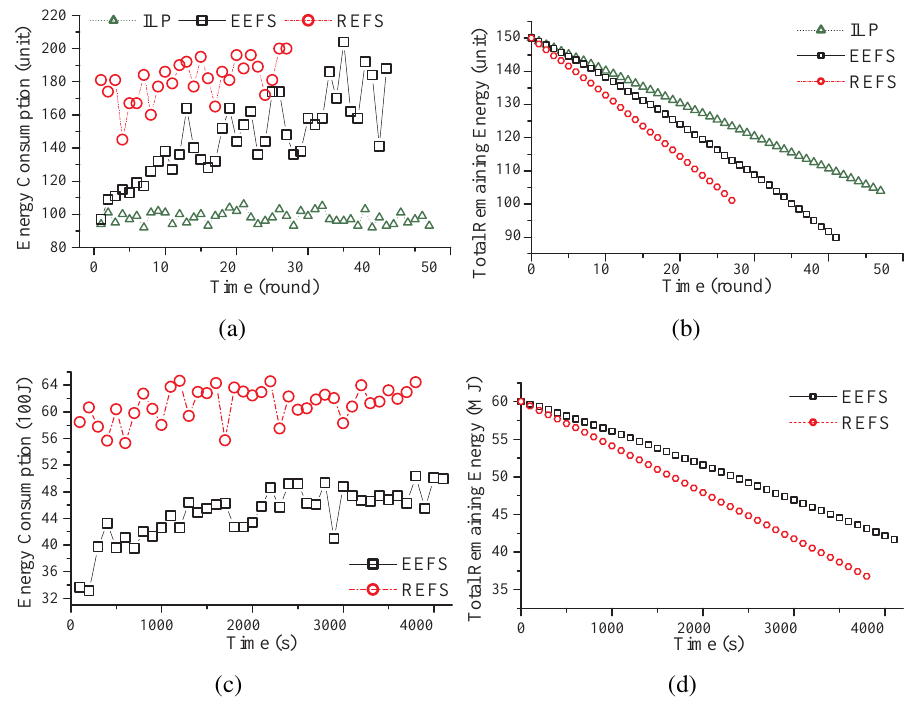
Figure 6. The energy consumption and the remaining energy in each round for the some run. (a) The energy consumption and (b) the remaining energy in each round for some run in scenario 1. (c) The energy consumption and (d) the remaining energy in each round for some run in scenario